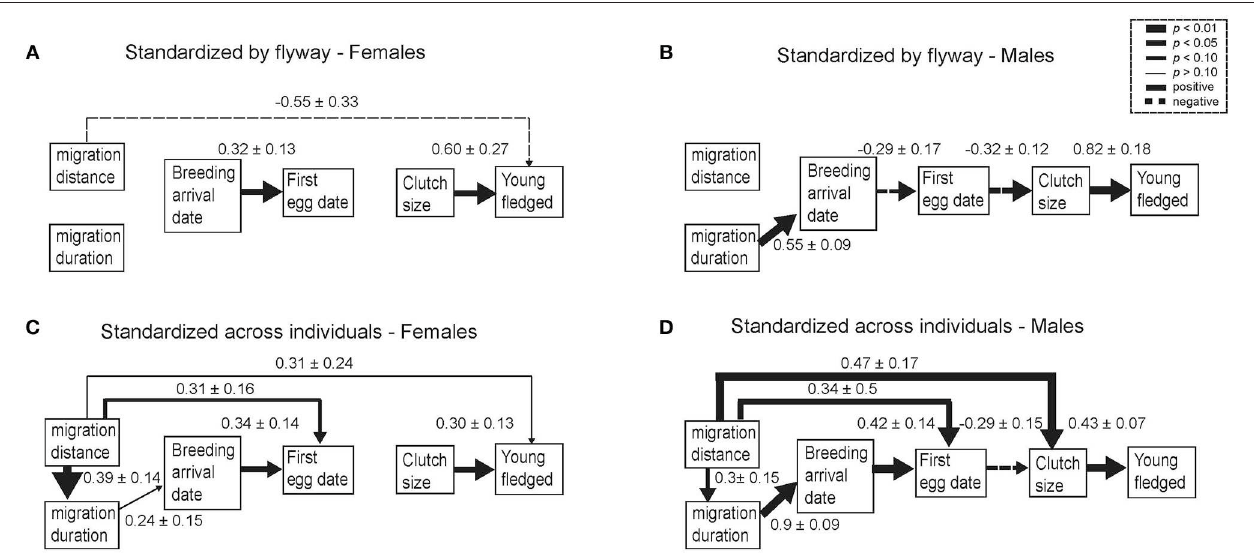
FIGURE 2 | Path diagrams for the factors that influence the number of young fledged for female and male tree swallows using variables standardized by flyway (A,B) and standardized across individuals (C,D) . Path models represent the most parsimonious models as determined using information theory. The thickness of each arrow is scaled to reflect the magnitude of the partial regression coefficients and the corresponding levels of significance (see legend on figure). Solid lines indicate positive relationships and dashed lines indicate negative relationships. All data were standardized prior to analysis and all partial regression coefficients are comparable across all relationships. Sample sizes are: N = 33 Eastern flyway females; N = 20 Eastern flyway males; N = 13 Central flyway females; and N = 23 Central flyway